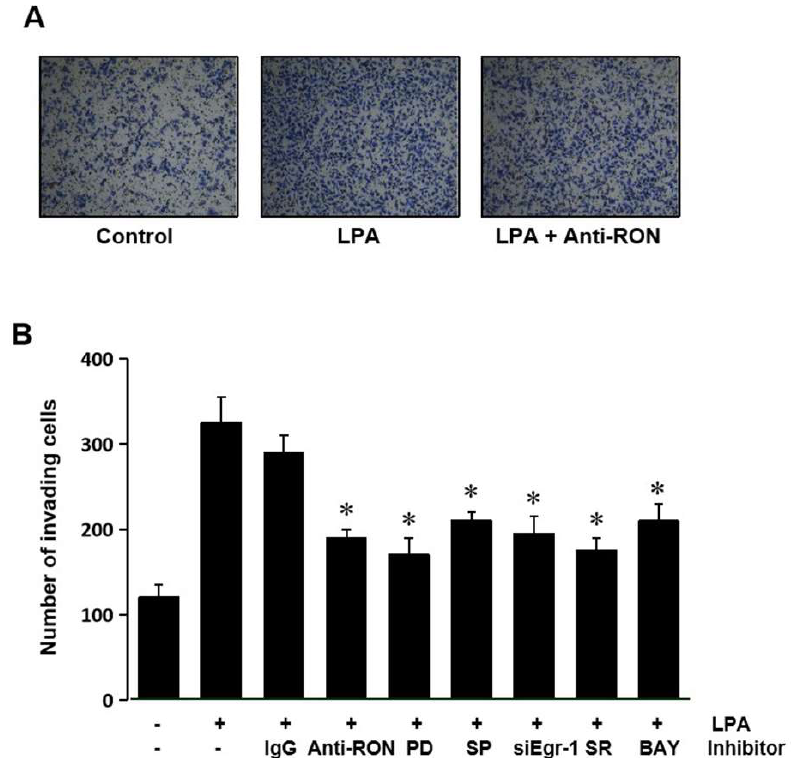
Figure 8. LPA effect on T24 cell invasiveness. ( A ) T24 cells (10 5 ) were seeded onto Matrigel coated membranes of a chamber with 5 μM LPA for 24 h, in the presence or absence of anti-RON antibody (200 ng/mL). After incubation, the cells that had invaded the lower chambers were fixed with 100% methanol and stained with a Diff-Quick stain kit. Images of the invading T24 cells were obtained using a phase contrast light microscope. ( B ) T24 cells (10 5 ) were seeded onto Matrigel coated membranes of a chamber with 5 μM LPA for 24 h, in the presence or absence of non-specific IgG (200 ng/mL), anti-uPA antibody (200 ng/mL), anti-uPAR antibody (200 ng/mL), siEgr-1 (20 nM, cells transfected with Egr-1 siRNA oligonucleotides for 48 h before LPA treatment), PD98059 (PD, 50 μM), SB203580 (SB, 10 μM), SP600125 (SP, 10 μM), SR11032 (SR, 1 μM), and BAY11-7082 (BAY, 10 μM). After incubation, the cells that had invaded the lower chambers were counted. The bars show the mean and SD from three measurements. * p < 0.05 vs. LPA only.